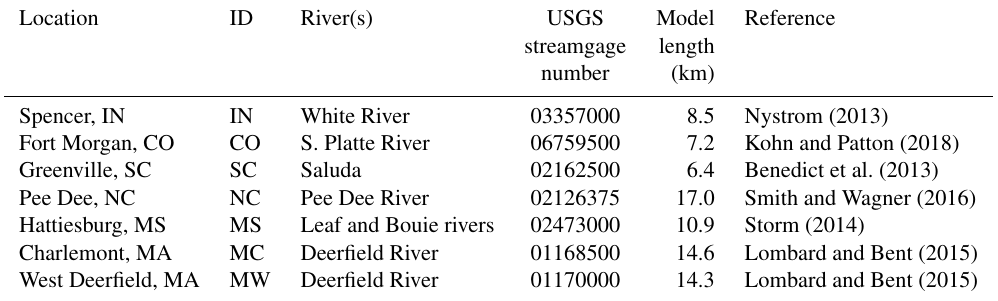
Figure 3. USGS study sites used in this study. For each study site the location, ID, and river(s) are provided. Sources of the background imagery include ESRI, DigitalGlobe, Earthstar Geographics, CNES/Airbus DS, GeoEye, USDA FSA, USGS, Getmapping, Aerogrid, IGN, IGP, and the GIS user community. Table 1. USGS study sites used in this study. For each study site the location, ID, river(s), USGS streamgage, model length, and reference are